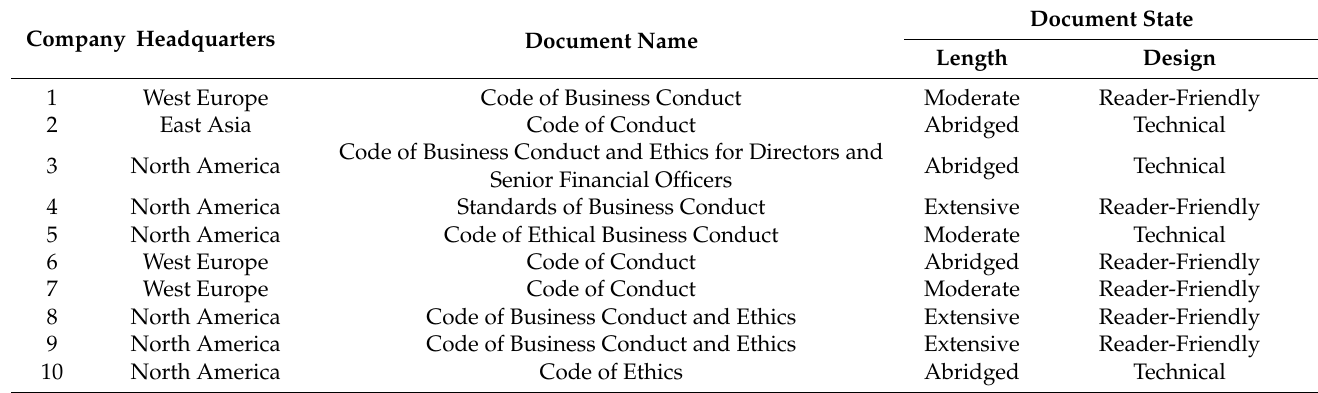
Table 1. General characteristics of the analyzed codes of conduct.